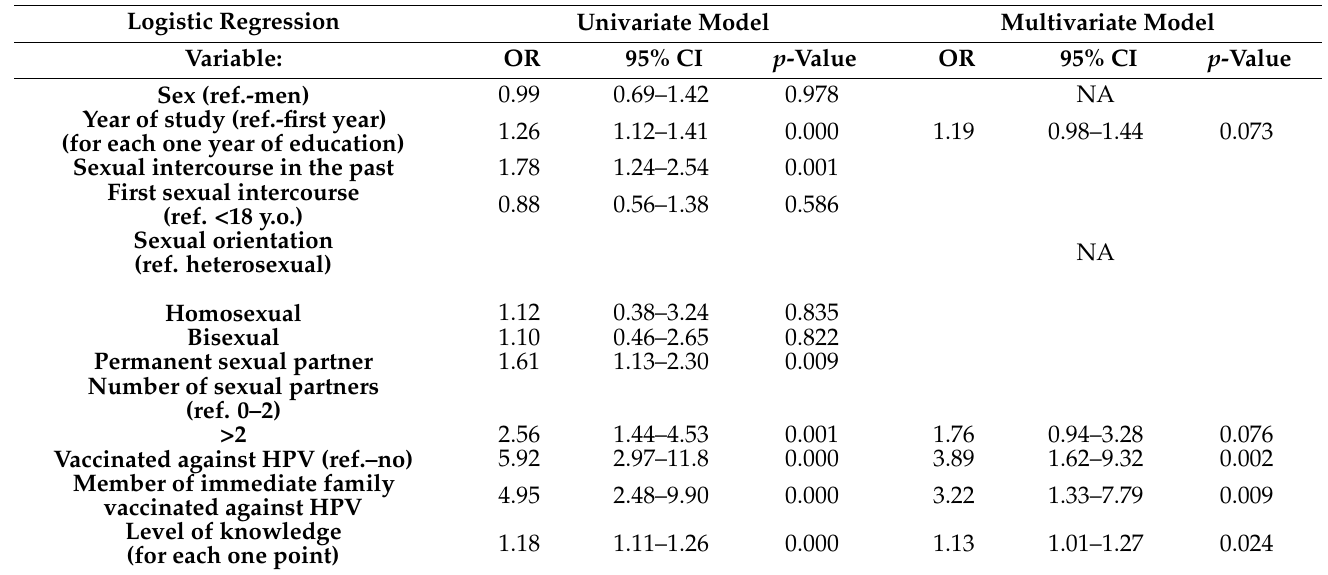
Table 4. Factors influencing medical students’ intention to recommend HPV vaccination to women (univariate and multivariate